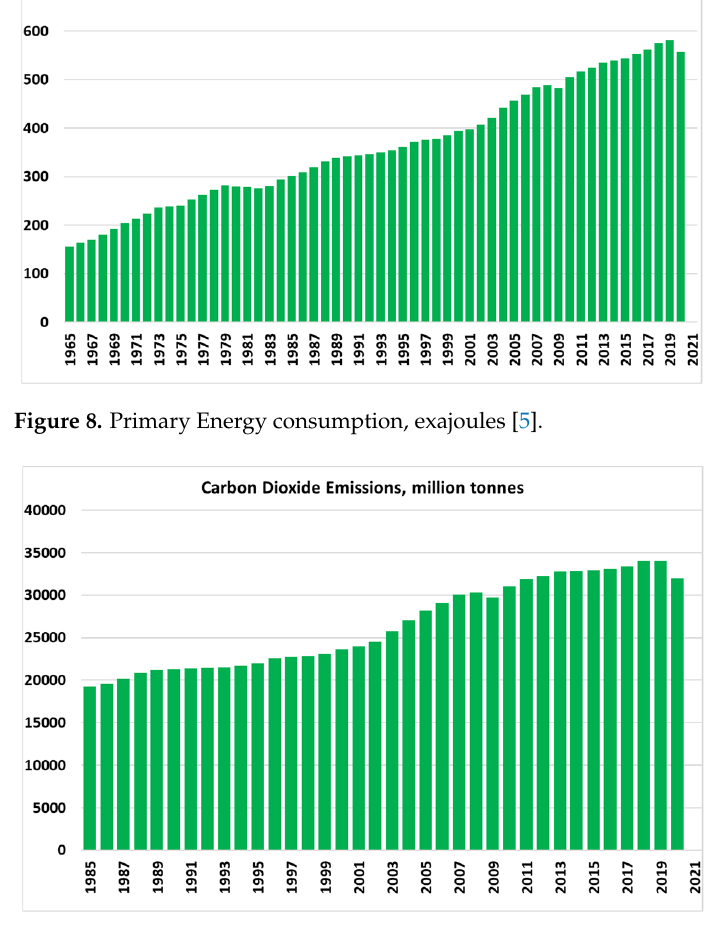
Figure 9. Carbon dioxide emissions, million tones [5].